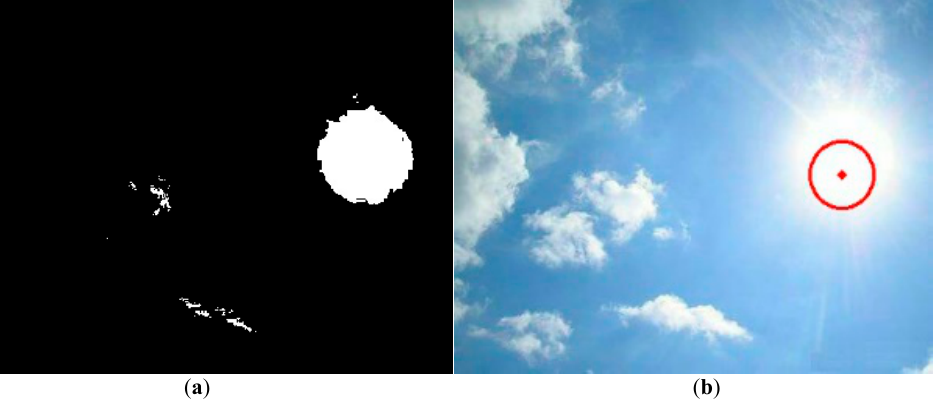
Figure 8. The binary image of Figure 1 is shown in ( a ); The evaluated center of the sun using the Hough transform method is shown as a diamond point in ( b ).